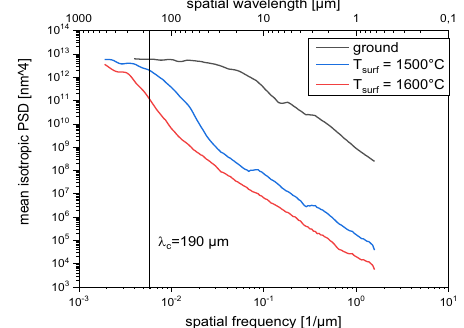
Fig. 3. Isotropic power spectral density (PSD) function of ground and plasma polished surface.